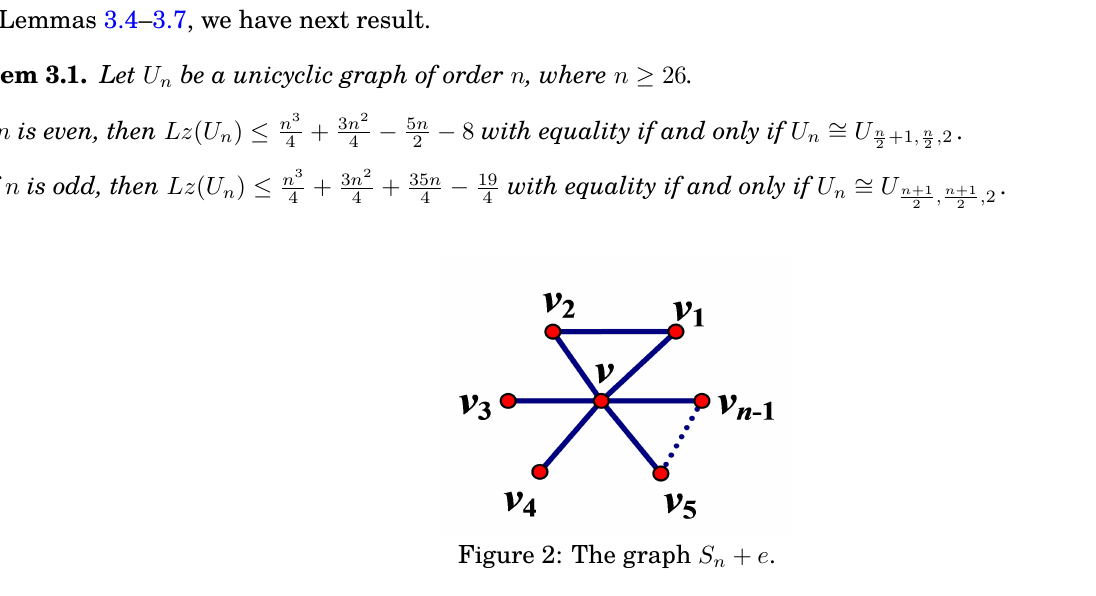
Figure 2: The graph S